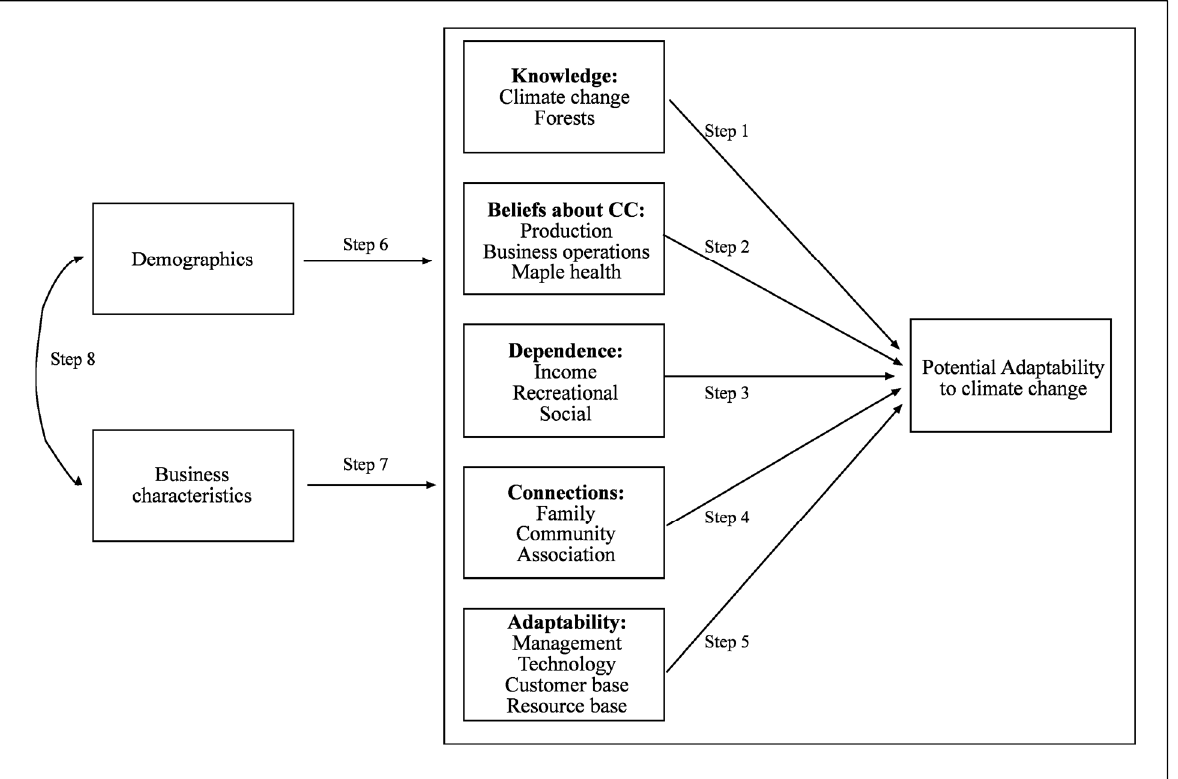
Figure 3. Step-by-Step Process Used to Conduct the Path